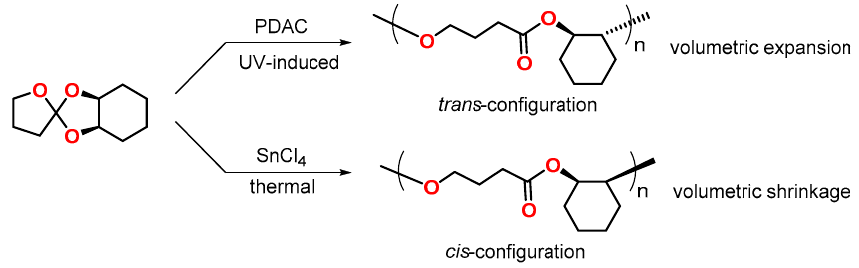
Figure 11. Regiospecific cationic polymerization of cis -2,3-tetramethylene-1,4,6-triox-